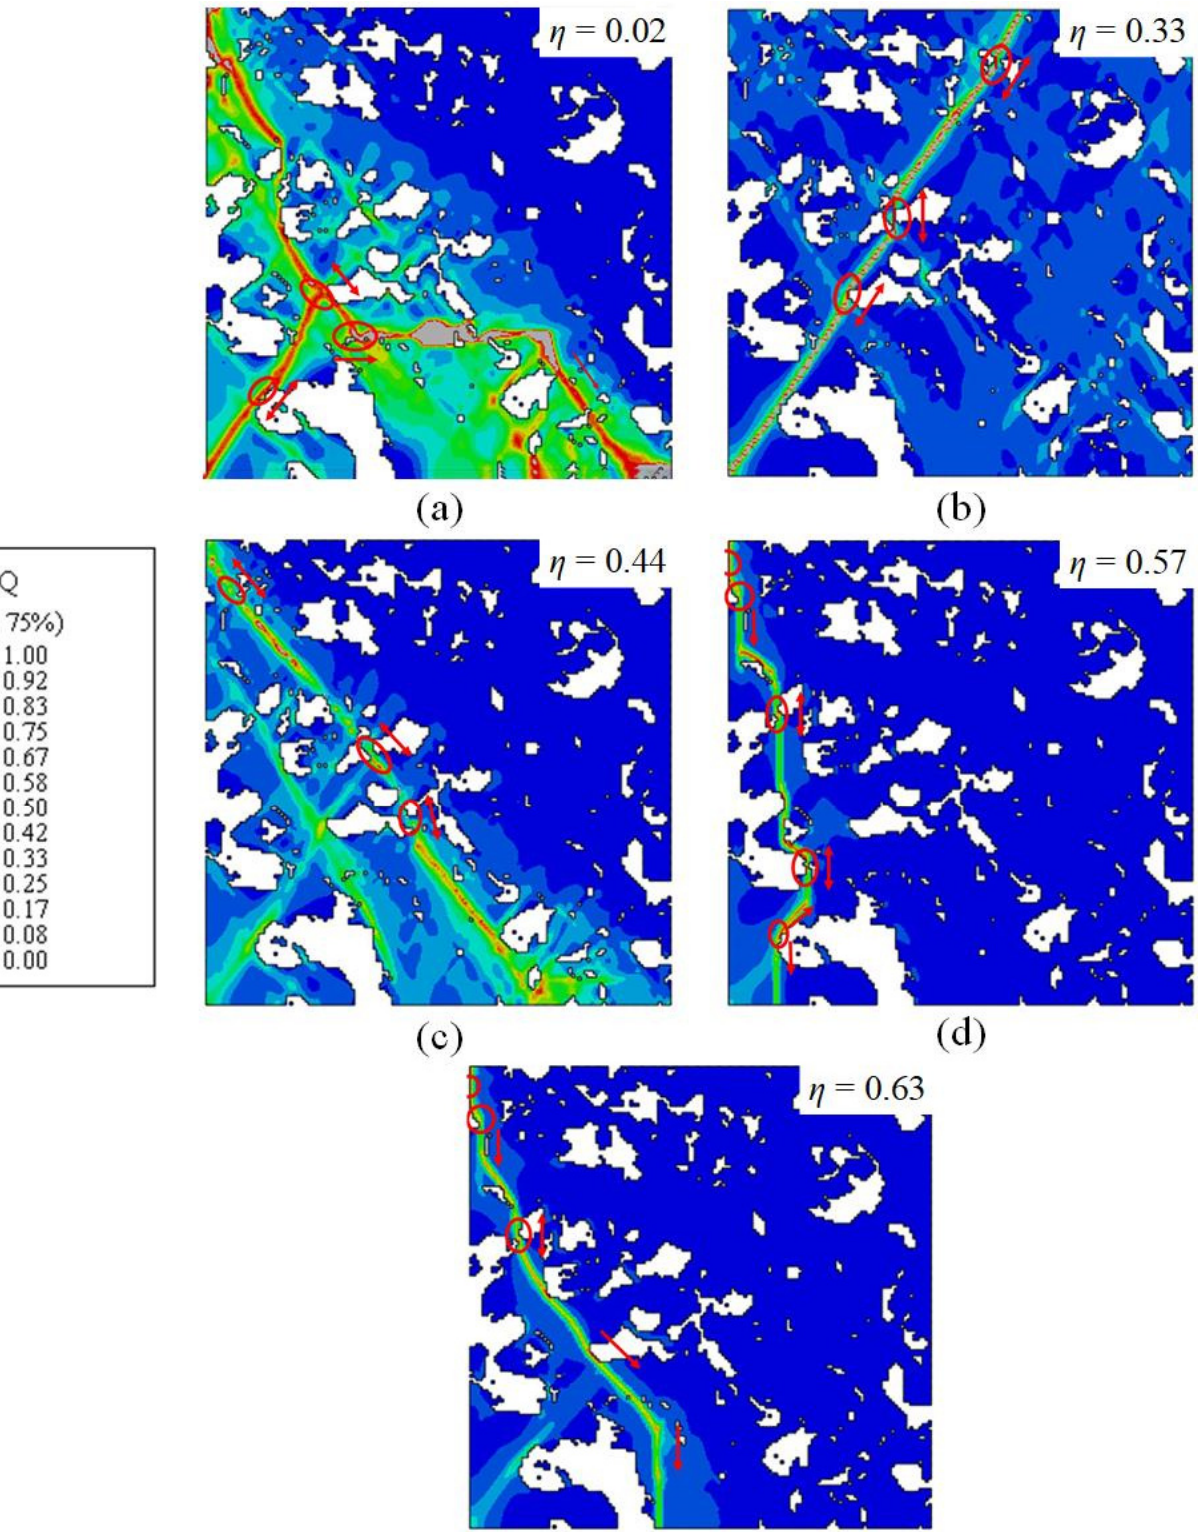
Figure 20. Calculated PEEQ in RVE under different loading conditions for the B/M microstructure (80%B + 20%M): ( a ) pure shear; ( b ) uniaxial tension; ( c ) uniaxial tension with a central hole; ( d ) plane strain tension; ( e ) equi-biaxial tension (white zones indicate the martensite phase, red circles denote the initiation positions of the failure and arrows indicate the directions of